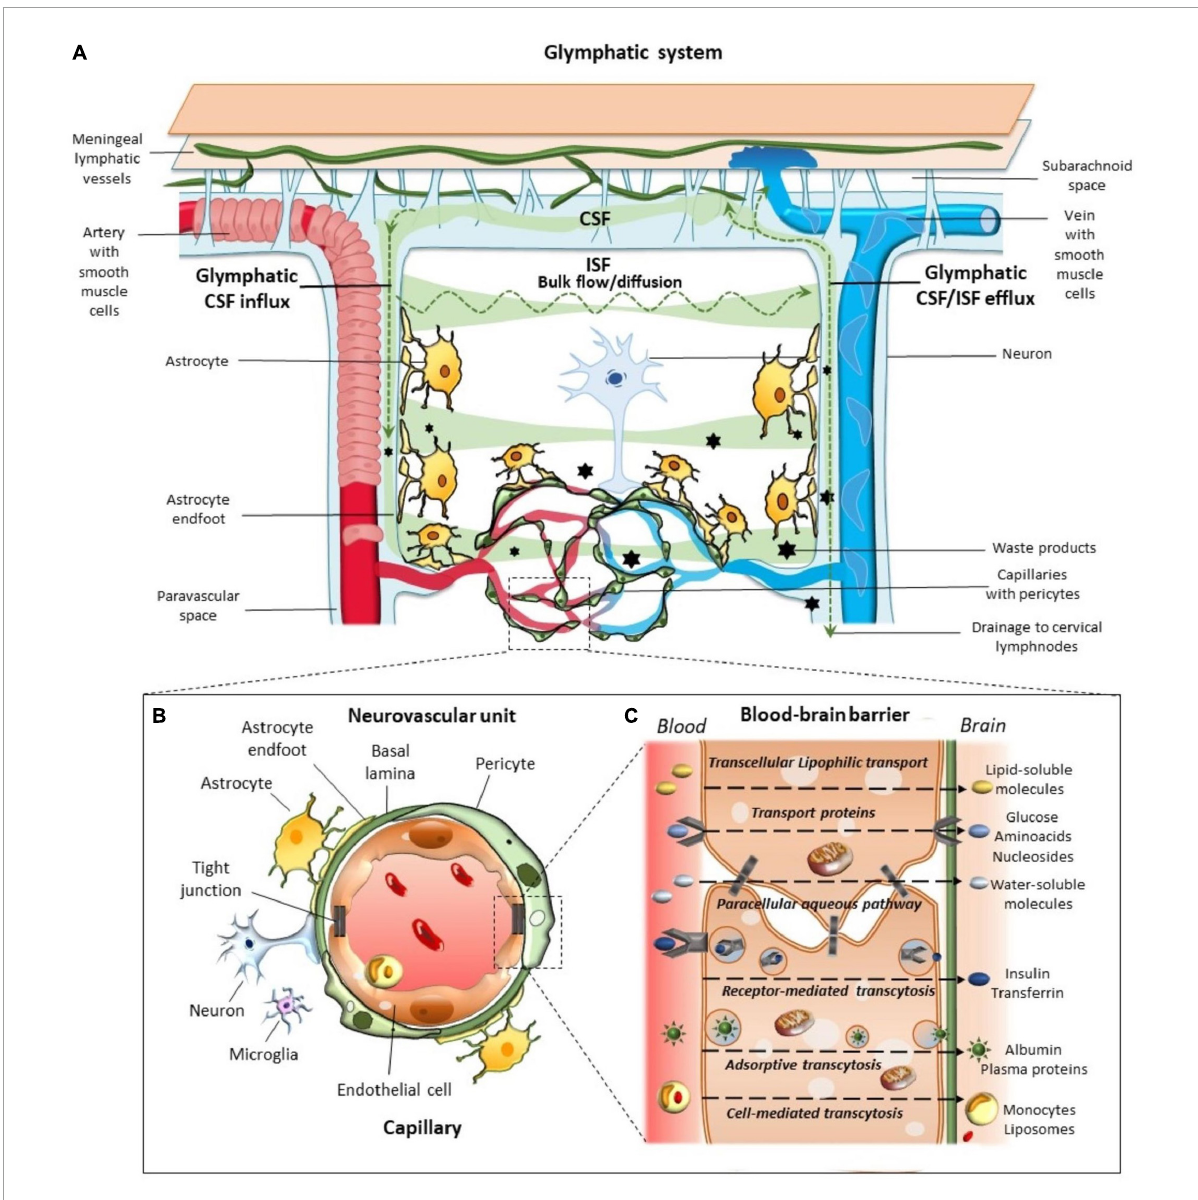
FIGURE3 The glymphatic system. This system aids in the brain’s transport, movement, and removal of solutes. (A) Cerebrospinal fluid (CSF) enters via para-arterial spaces (red) and mixes with interstitial fluid (ISF) (Iliff et al., 2012). The CSF-ISF mix enters the para-venous space through the AQP4 channels and exits via the para-venous efflux pathway (blue) (Shetty and Zanirati, 2020). (B) Neurovascular Unit. Complex unit, with astrocyte end-feet enclosing the blood vessels (Sakai and Nishino, 2021). (C) Blood-Brain Barrier exchange of metabolites to maintain brain homeostasis (Keable et al., 2016). Figure from Natale et al.